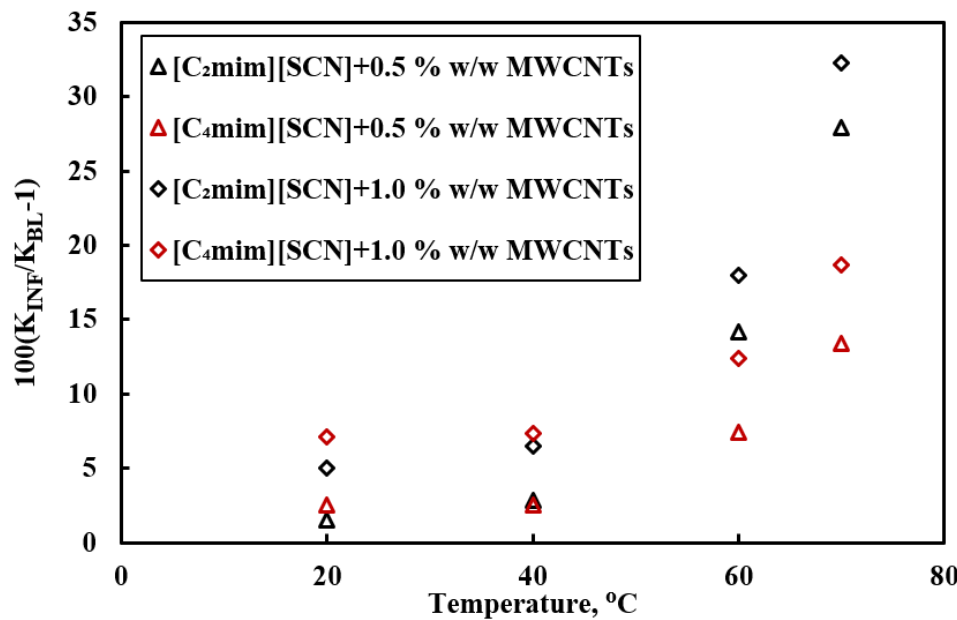
Figure 13. Enhancement ratio of the thermal conductivity of MWCNTs-enhanced ILs as a function of nanoparticle concentration and temperature with [SCN] anion [63]. Reproduced with permission from [França], [Ind. Eng. Chem. Res.]; published by [ACS], 2018.